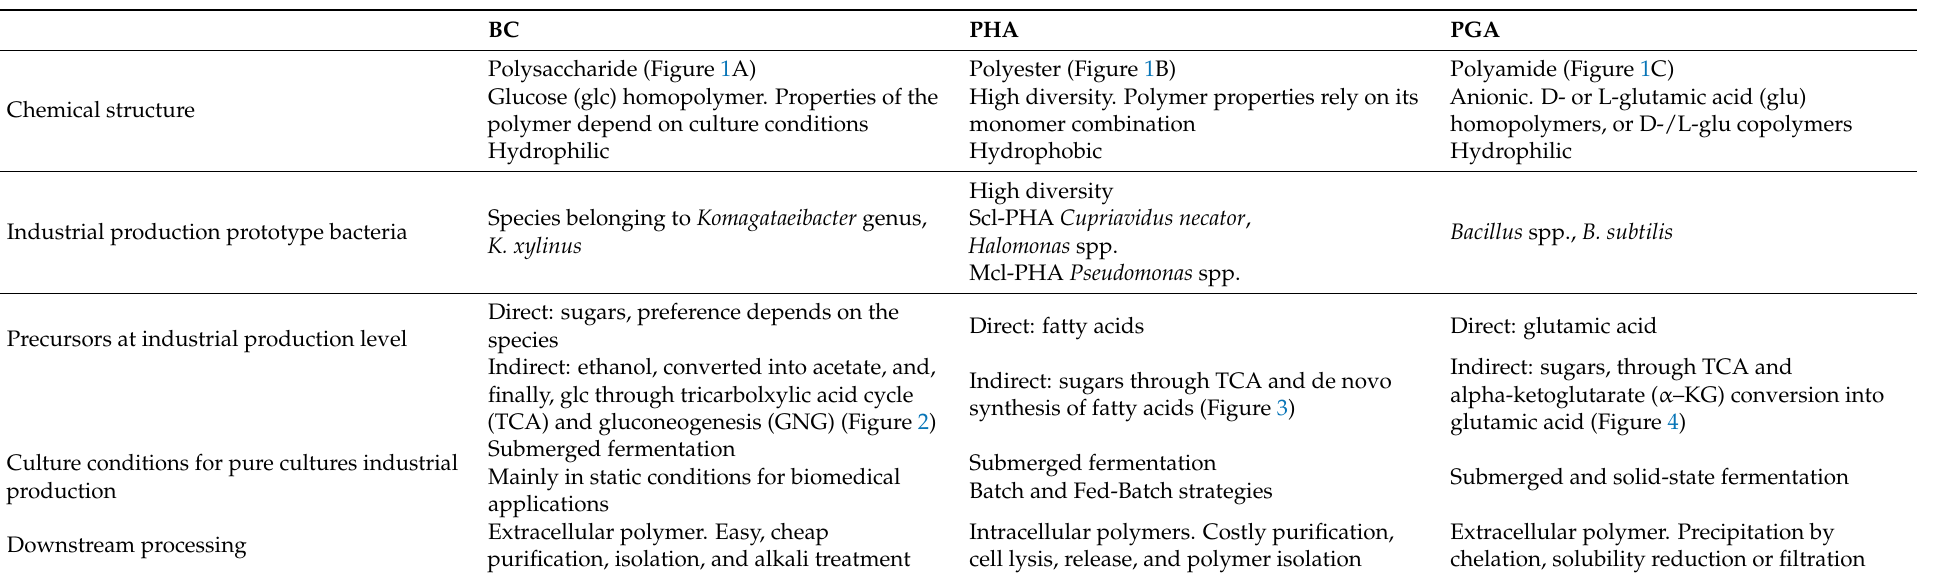
Table 1. Main characteristics of the model bacterial polymers BC, PHA, and